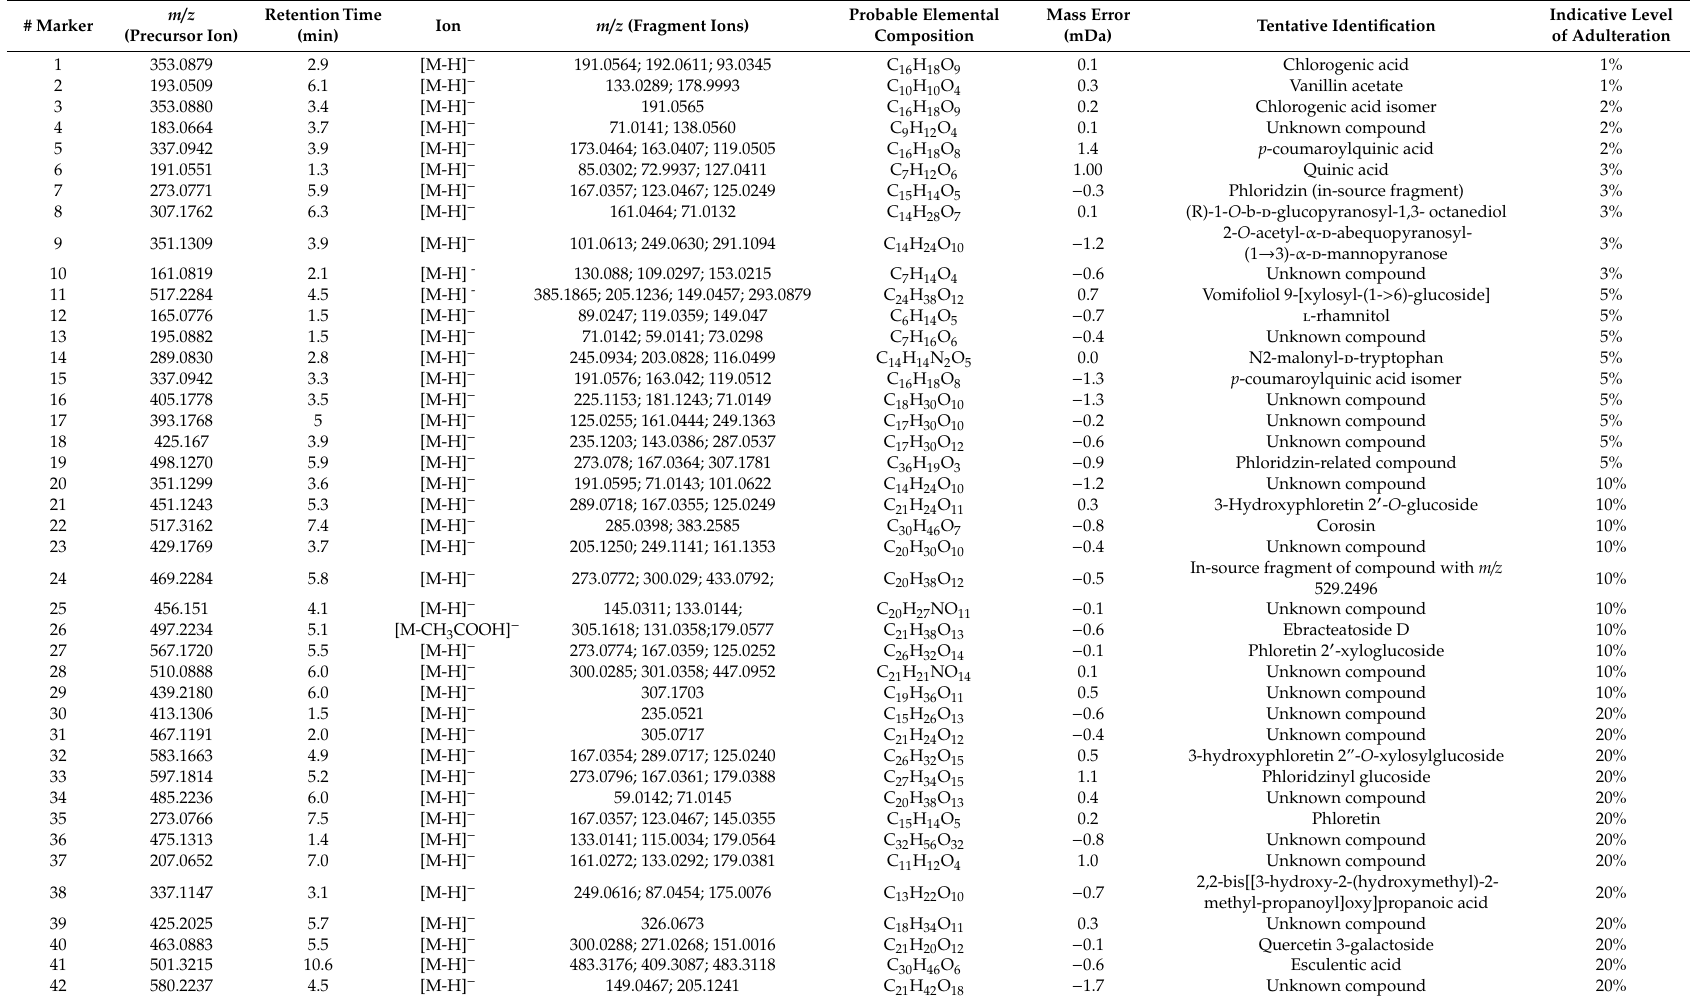
Table 3. Tentative identification of characteristic marker compounds indicating pomegranate juice adulteration from apple